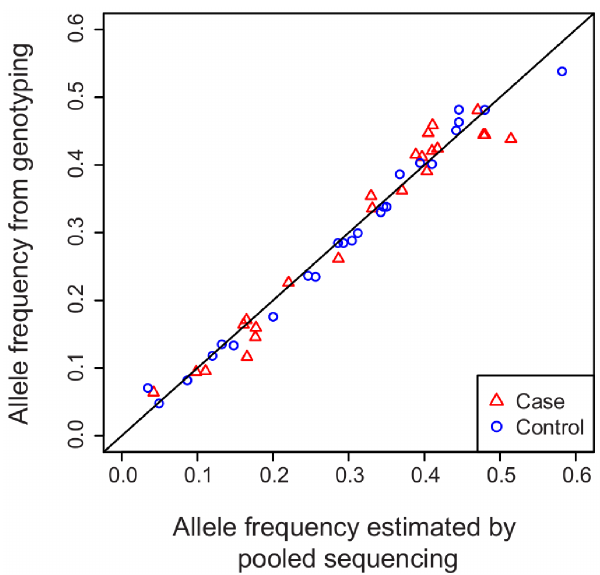
Figure 1. Allele frequencies estimated from pooled sequencing in comparison to Affymetrix genotyping. Allele frequencies for cases (red triangles) and controls (blue circles) are shown for 24 SNPs shared between the two assays. The Affymetrix genotype data are